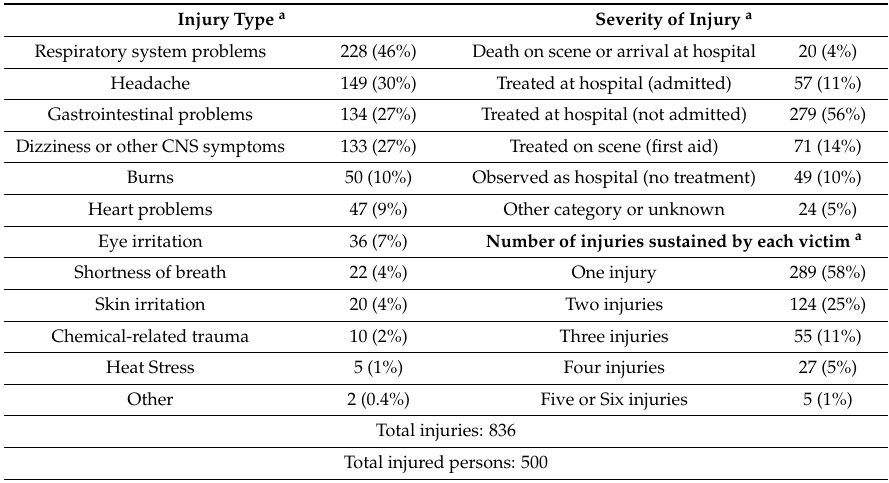
Table 2. Number, type, and severity of injuries that resulted from NTSIP-eligible toxic substance releases, North Carolina, 2010–2015.